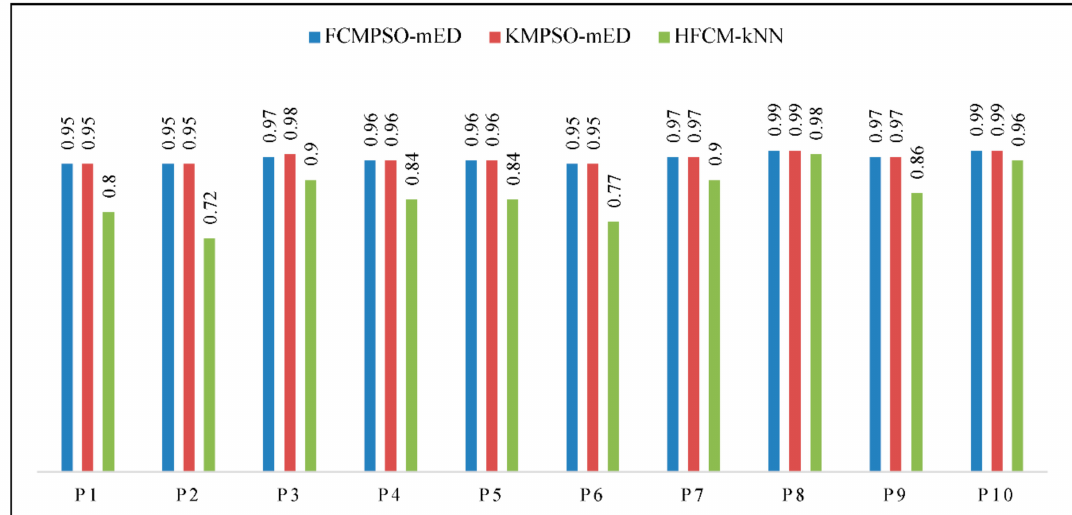
Figure 10. Comparison of the FCMPSO-mED, KMPSO-mED, and HFCM-kNN